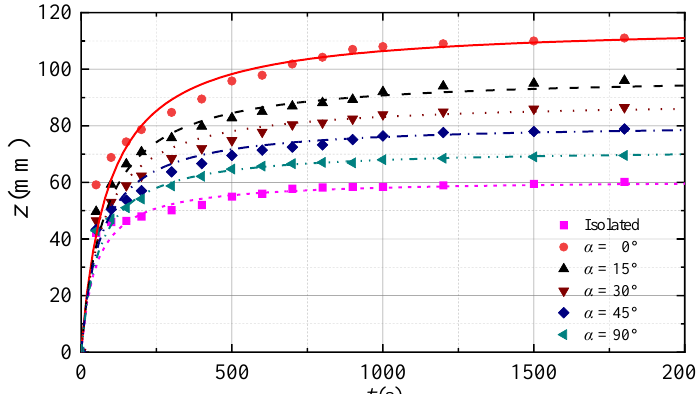
Figure 9. Temporal developments of scour depth for isolated and two crossing pipelines. Figure 10. Temporal developments of scour depth for isolated and two crossing